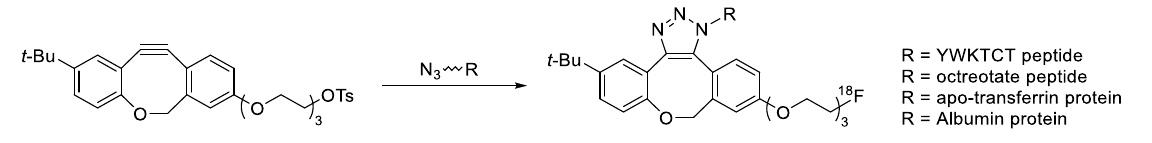
Figure 3. Radiolabeling of peptides or proteins using 18 F-labeled ODIBO.